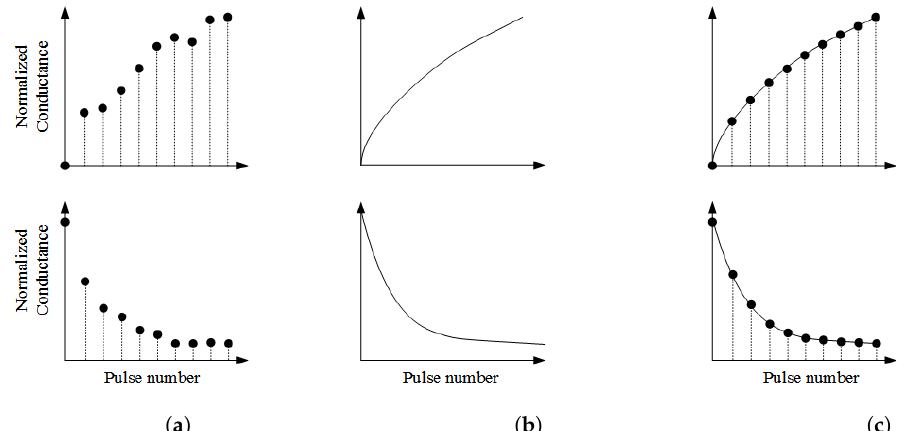
Figure 5. Generation process of the quantized conductance; ( a ) normalization to use the measured conductance as a weight; ( b ) after extracting the value of alpha using normalized conductance, modeling the synaptic device; ( c ) sampling based on identical pulses to apply the device characteristics to a function